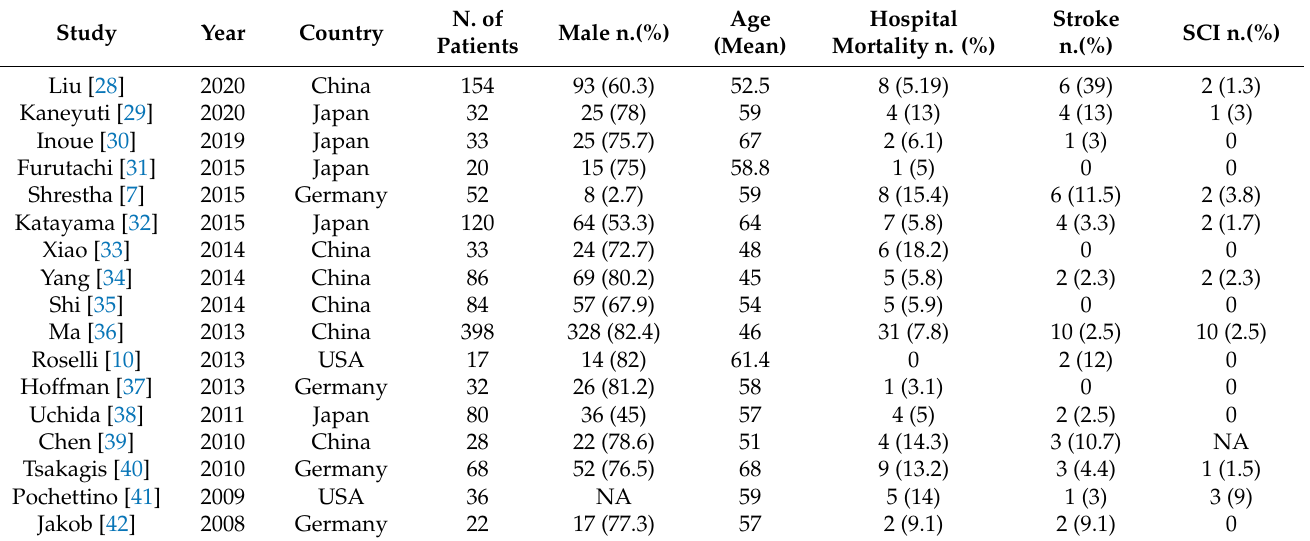
Table 1. Early outcomes after extensive ATAAD repair with Fthe ET